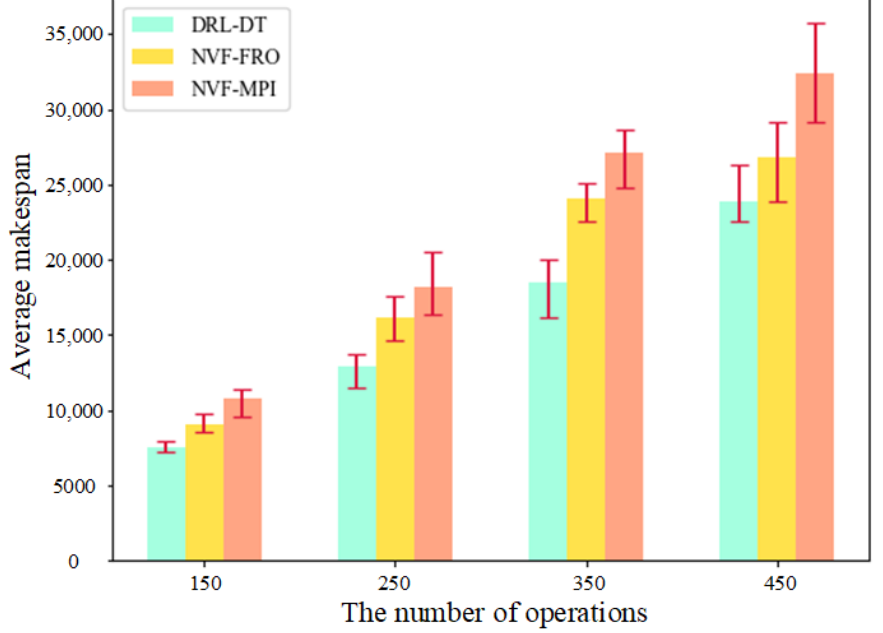
Figure 8. Performance comparison under different numbers of operations.